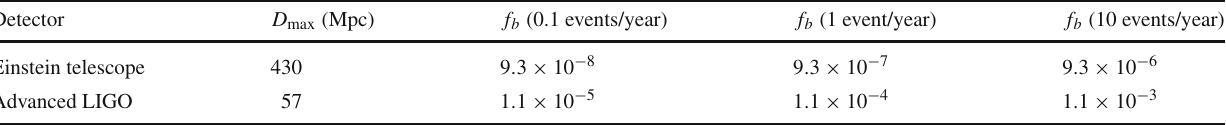
Table 1 Minimum fraction of axionic black hole binaries derived from three assumed detection rates (in brackets) for the Einstein Telescope and Advance LIGO. The maximum radius of the probed volume of the universe is also given